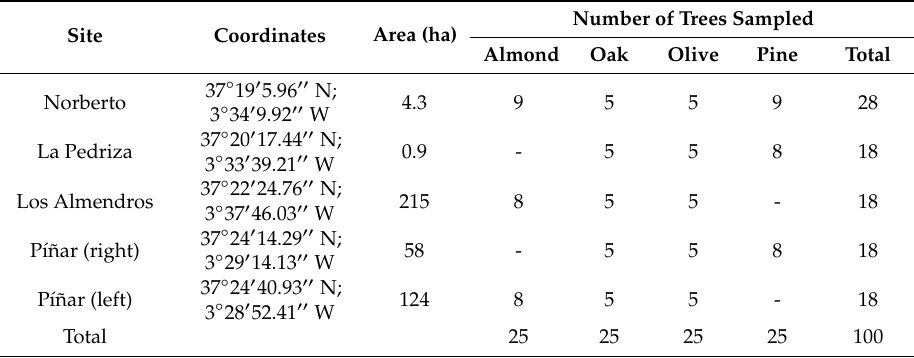
Table 1. Characteristics and availability of each tree species and number of tree species sampled in each site per month